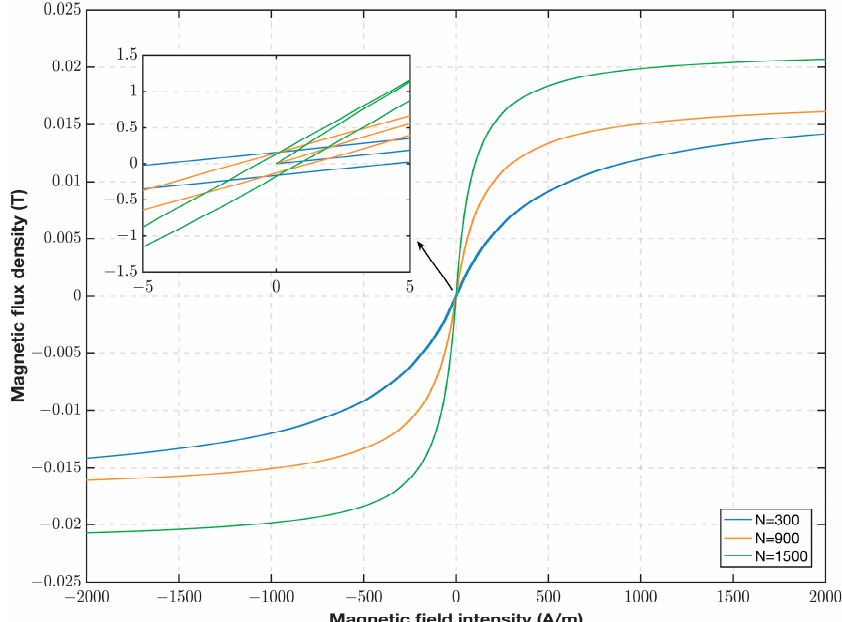
Figure 8. Hysteresis curves for different number of turns of the CHAN model.